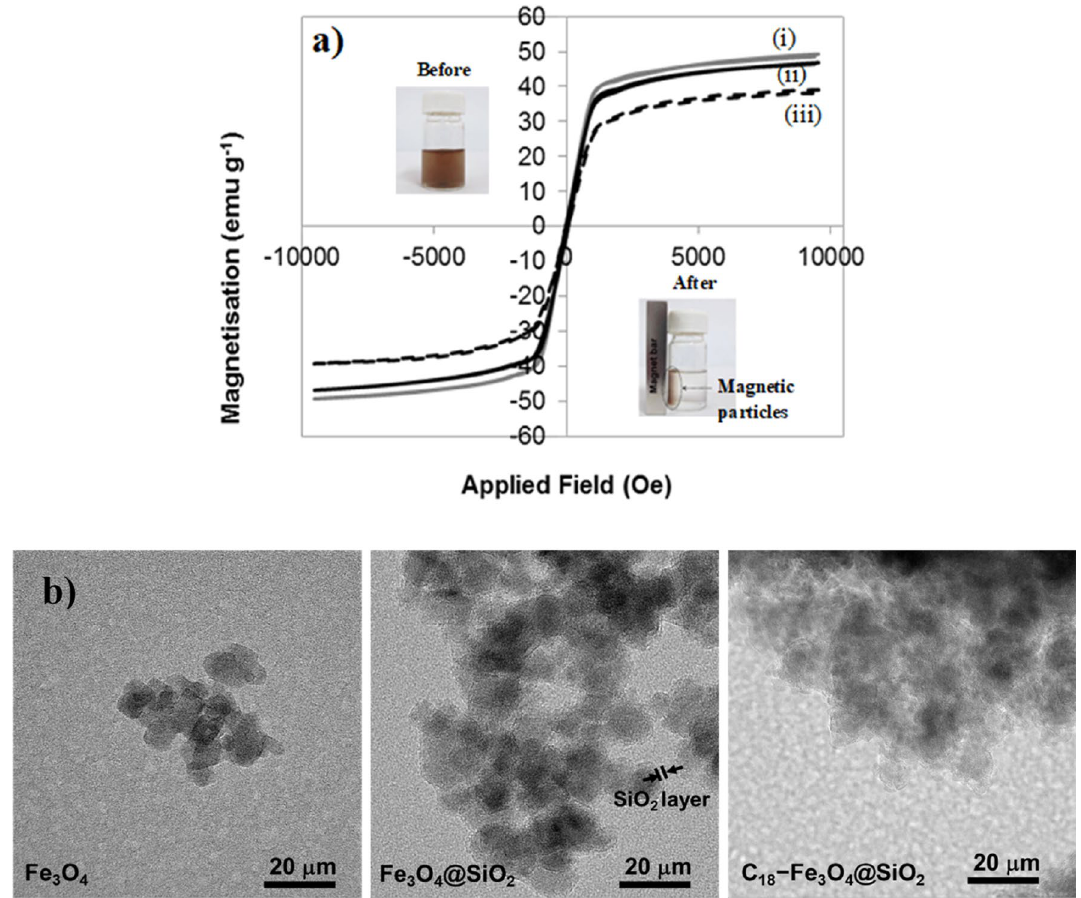
Figure 3. ( a ) Magnetic hysteresis curves of (i) Fe 3 O 4 , (ii) Fe 3 O 4 @SiO 2 , and (iii) Fe 3 O 4 @SiO 2 @C 18 particles at room temperature. The images in the insets show Fe 3 O 4 @SiO 2 @C 18 particles in an aqueous solution before and after separation using an external magnetic field. ( b ) TEM image of Fe 3 O 4 , Fe 3 O 4 @SiO 2 , and Fe 3 O 4 @SiO 2 @C 18 314.3 ± 59.4 µg P g −1 (Table S1). The relative standard deviation (RSD) of the mean q e showed acceptable HOR-